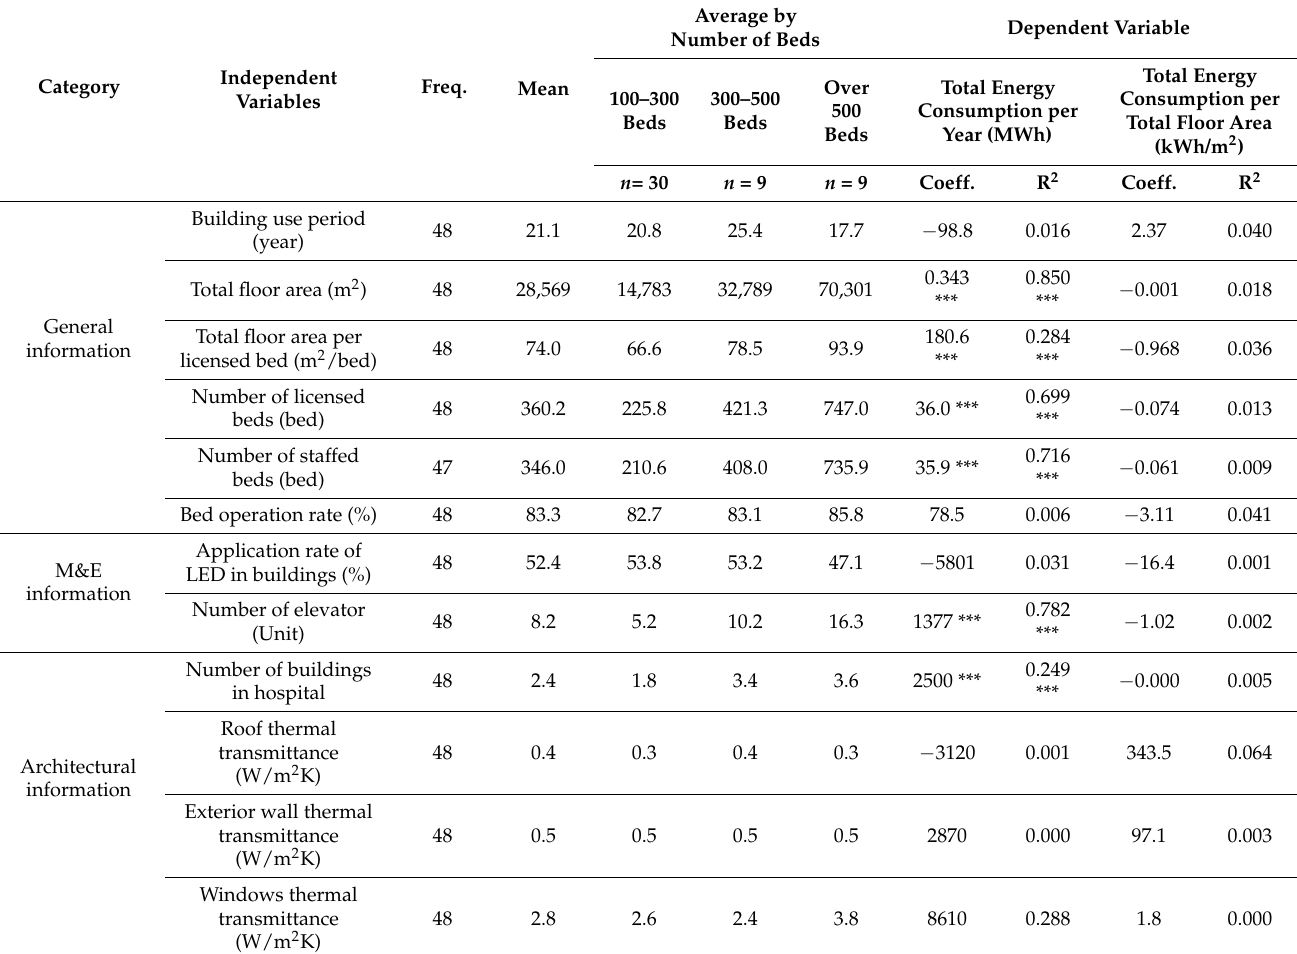
Table 8. Results of the single regression